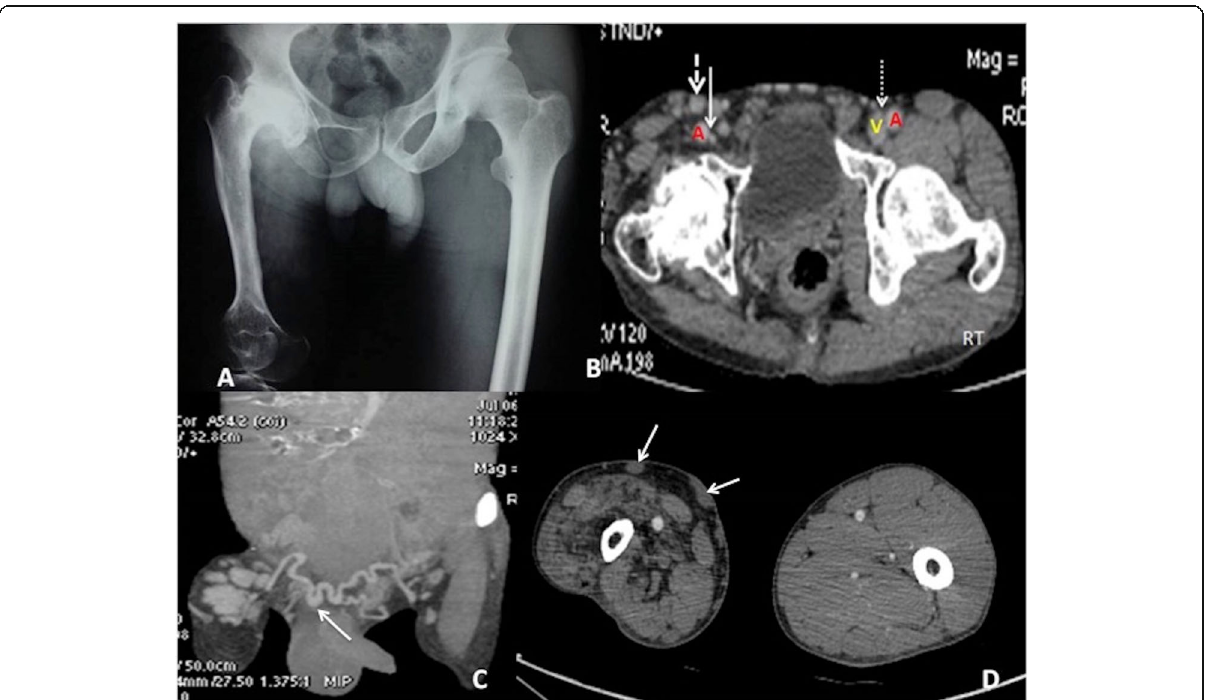
Fig. 2 a X-ray of pelvis including bilateral hip joints and proximal femurs show shallow dysplastic right acetabulum, osteonecrosis of the femoral head, decreased hip joint space, coxa vara deformity, and increased cortical thickness of the short right femur. b Axial contrast enhanced CT angiography image demonstrates superficial varicosities (interrupted arrow) and absent external iliac vein on right side (arrow). Normal relationship of artery (A) and vein (V) on left side with presence of external iliac vein (dotted arrow). c Coronal contrast enhanced CT venography image (delayed phase) showing venous arch in anterior abdominal wall (arrow) connecting venous system of both lower limbs. d Axial contrast enhanced CT angiography image demonstrates muscular atrophy of the right thigh and multiple subcutaneous varicosities